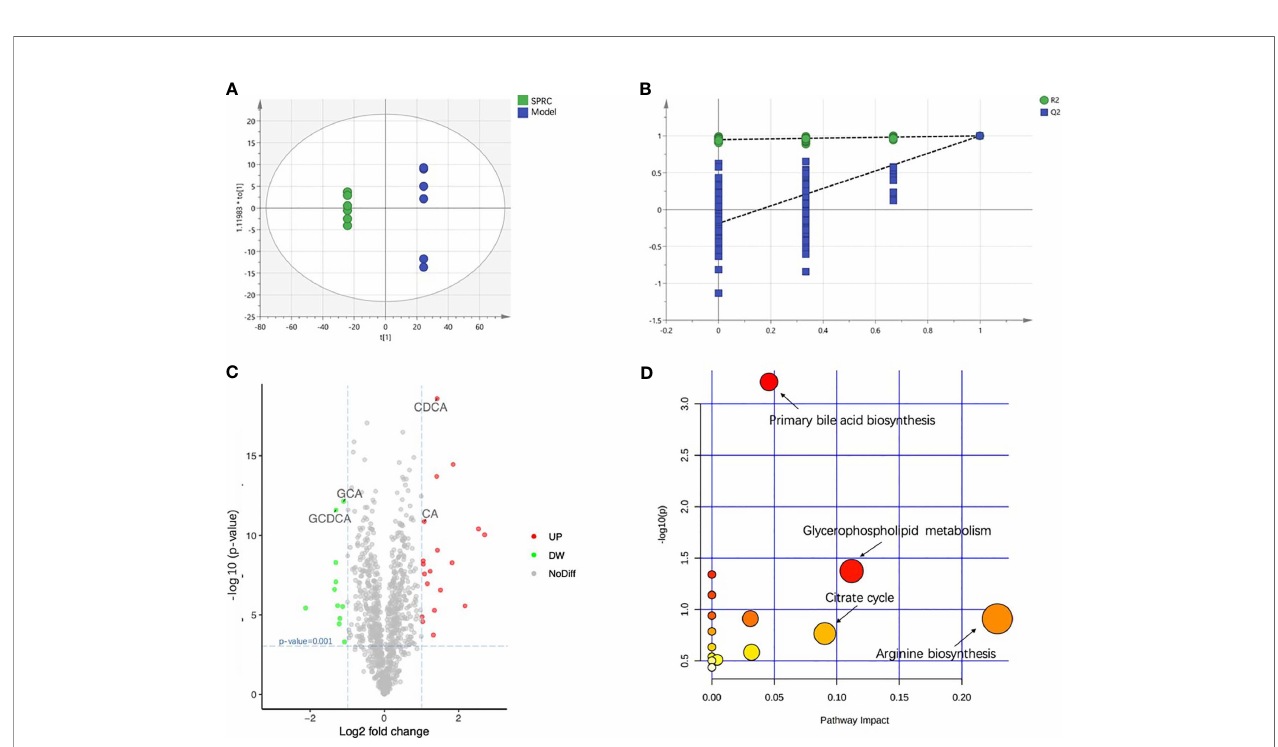
FIGURE 8 | SPRC altered bile acid metabolism. The relative concentrations of all 18 detected metabolites are presented in a heat map. (A) The score plot of the OPLS-DA model showed good separation of the Model and SPRC groups. (B) A 200-times permutation test of the corresponding model. The Y-axis intercepts were R2 (0, 0.742) and Q2 (0, − 0.438). (C) The volcano plot visually shows the crucial metabolites marked in green and red with absolute values of a log2-fold change greater than 1 and p-value less than 0.001. The relative concentrations of GCDCA, GCA, CDCA, and CA are also indicated in the plot with arrows. (D) Pathway analysis, combining pathway topology analysis and pathway enrichment analysis, annotated the signi fi cantly altered metabolites in pathways. The x-axis indicates the pathway impact, and the y-axis represents the pathway enrichment. The nodes with larger sizes and darker colors represent higher pathway impact values and greater pathway